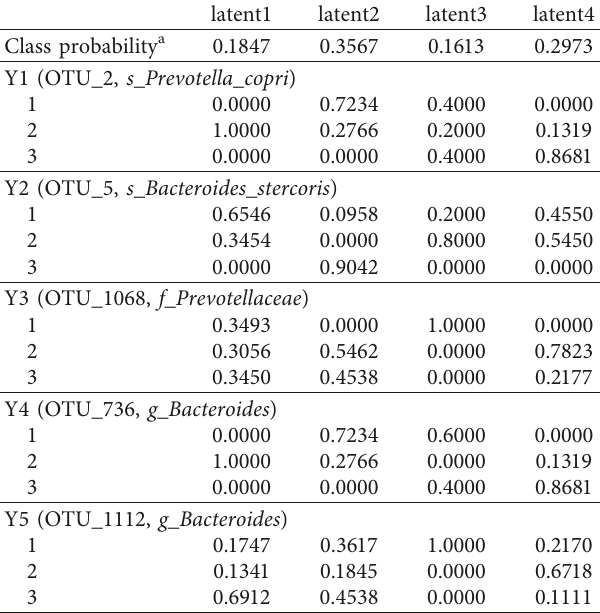
Table 4: Latent variable analysis based on the five identified